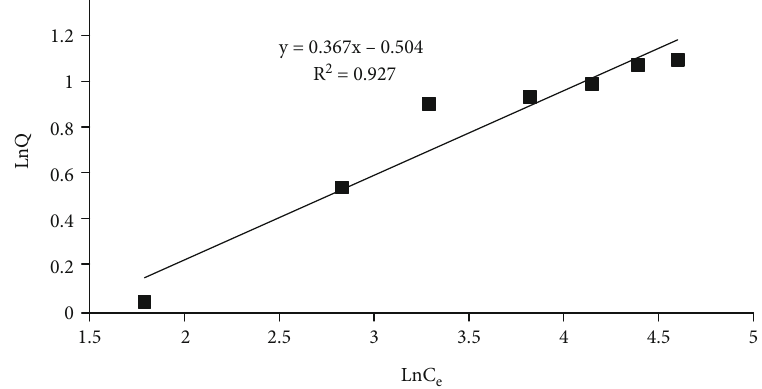
y = 0.367x – 0.504 R 2 = 0.927